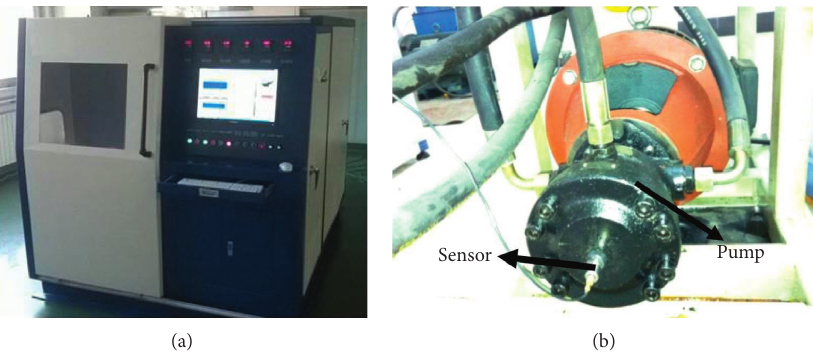
Figure 5: The experiment device. (a) The experiment platform of hydraulic pump. (b) Hydraulic pump and test